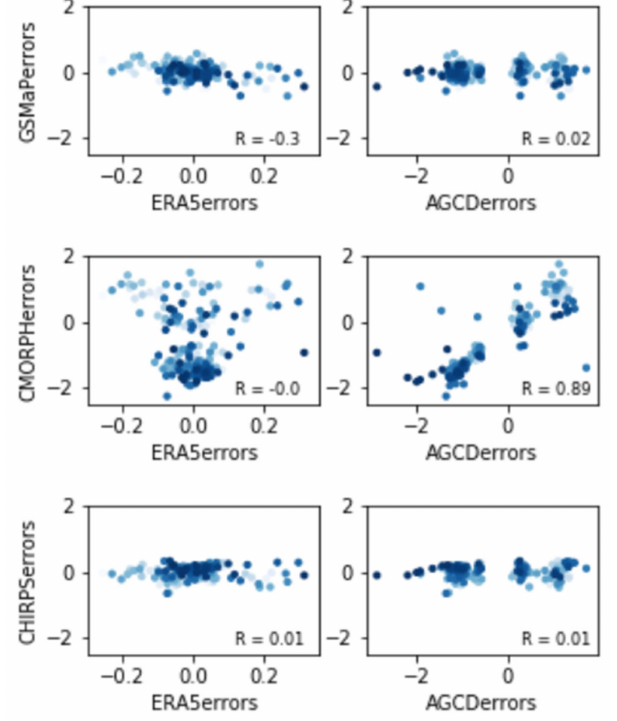
Figure 3. Scatterplot of monthly average precipitation errors (dataset minus MSWEP) across the study region for each SPE compared to ERA5 and AGCD. Units are in mm/day. The pale dots indicate months earlier in the study period and the dark dots represent months closer to the end of the study